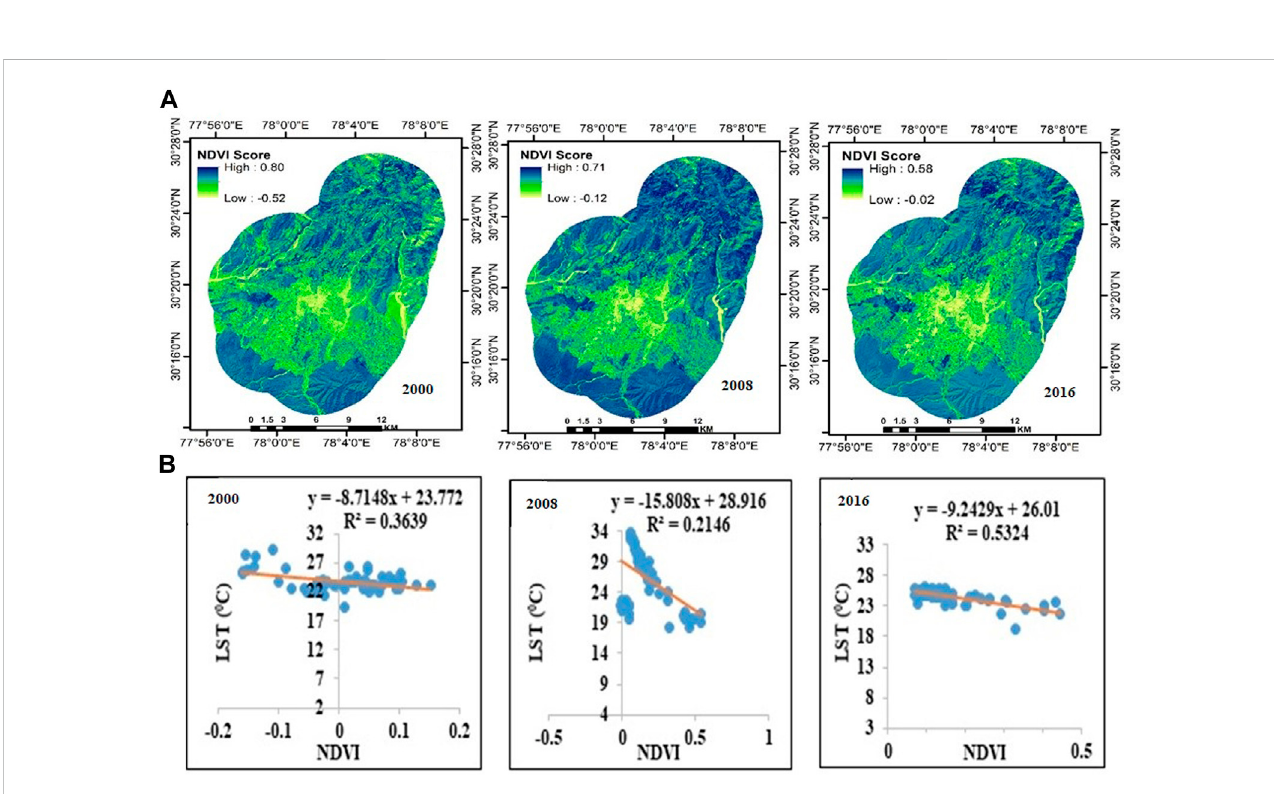
FIGURE 6 Change in NDVI (A) and degree of association of NDVI with LST (B) for Dehradun.